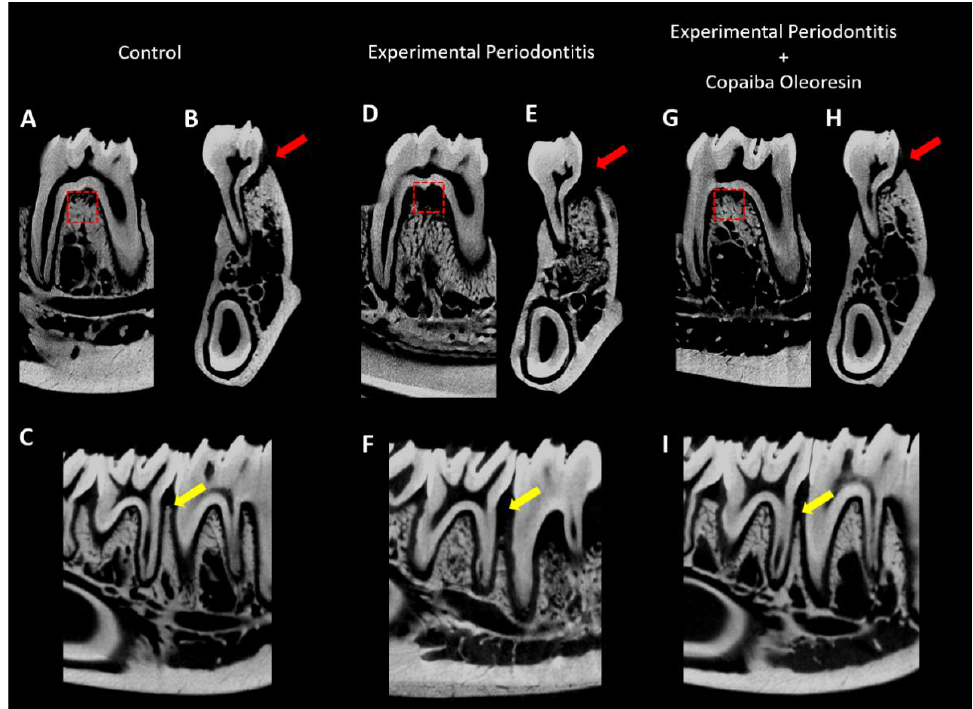
Figure 3. Sagittal ( A , C ) and coronal representative slices ( B ) of the animals’ hemimandible in the inferior first molar region of the control group, experimental periodontitis group ( D , E , F ), and experimental periodontitis + copaiba oleoresin group ( G , H , I ). Red squares indicate the region of interest for alveolar bone quality evaluation; red arrows highlight the bone loss differences between the groups; yellow arrows highlight the alveolar bone crest level in different groups.